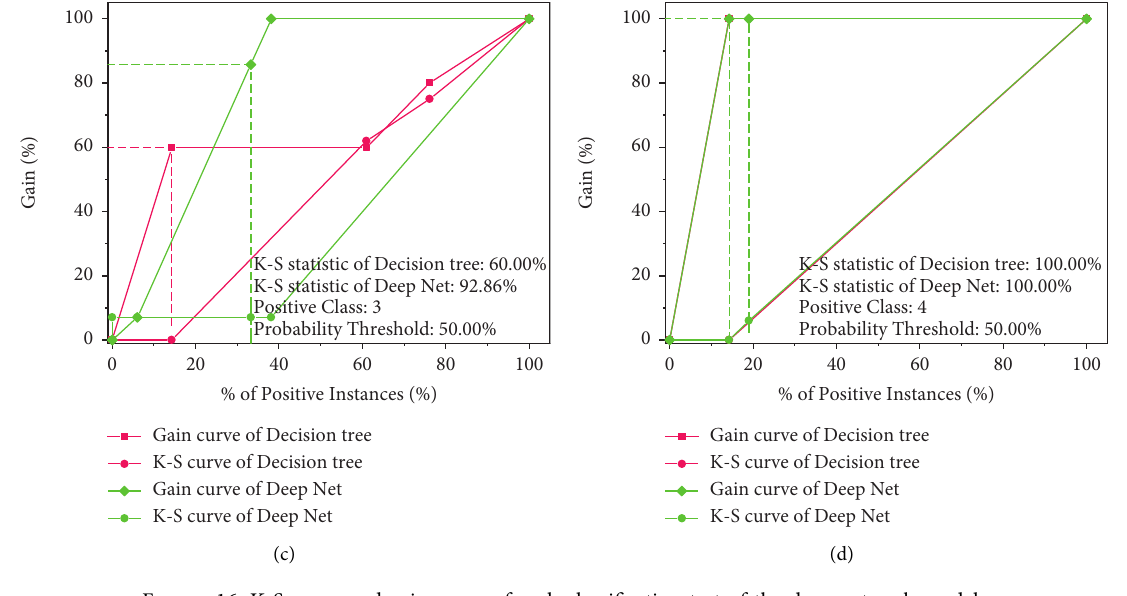
Figure 16: K-S curve and gain curve of each classification test of the deep network model.